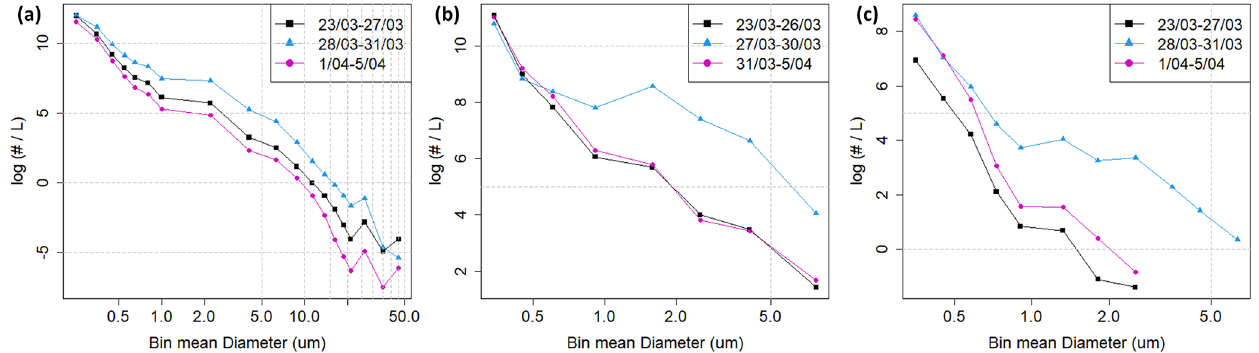
Figure 6. Particle size distributions for the OPCs: (a) LOAC (Bologna), (b) FAI (Trieste), and (c) GRIMM (Mt. Cimone). Abscissa values are in micrometers (µm), and ordinate values are in log (no.L − 1 ). The abscissa axis is on a logarithmic scale.